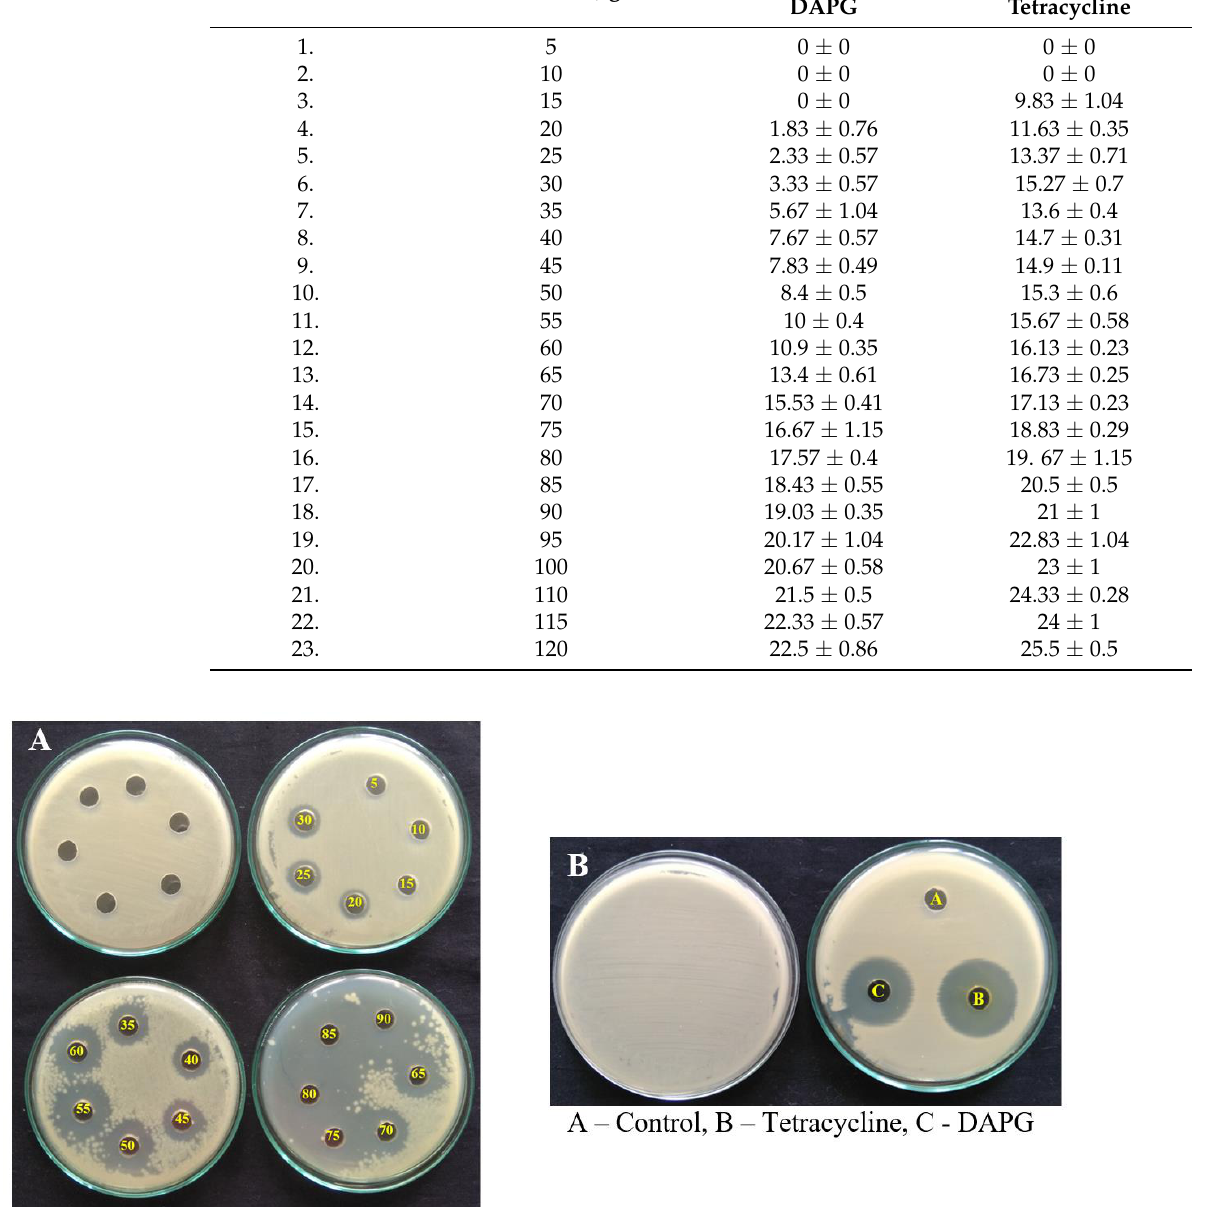
Figure 6. MIC of DAPG compound against R. solanacearum . ( A ) Different concentrations of DAPG metabolites against R. solanacearum and ( B ) 90 µg/mL concentration of tetracycline and DAPG. 3.9. Live/Dead Cell Assay of R. solanacearum Cells of R. solanacearum were treated with purified DAPG and they were observed under a high content screening imaging technique. Fluorescent dyes were used for visu- alizing intactness of cell membranes and nucleic acids. Cells with intact cell membranes showed green coloured cells, indicating live cells, and red coloured cells, considered as dead cells. Cells of R. solanacearum treated with DAPG showed a drastic reduction in viability compared to control. The DAPG treatment resulted in only 36% live cells and tetracycline (90 µ g/mL) treatment resulted in 29% viable cells (Table 4; Figure 7). Table 4. Live/dead assay of R. solanacearum.